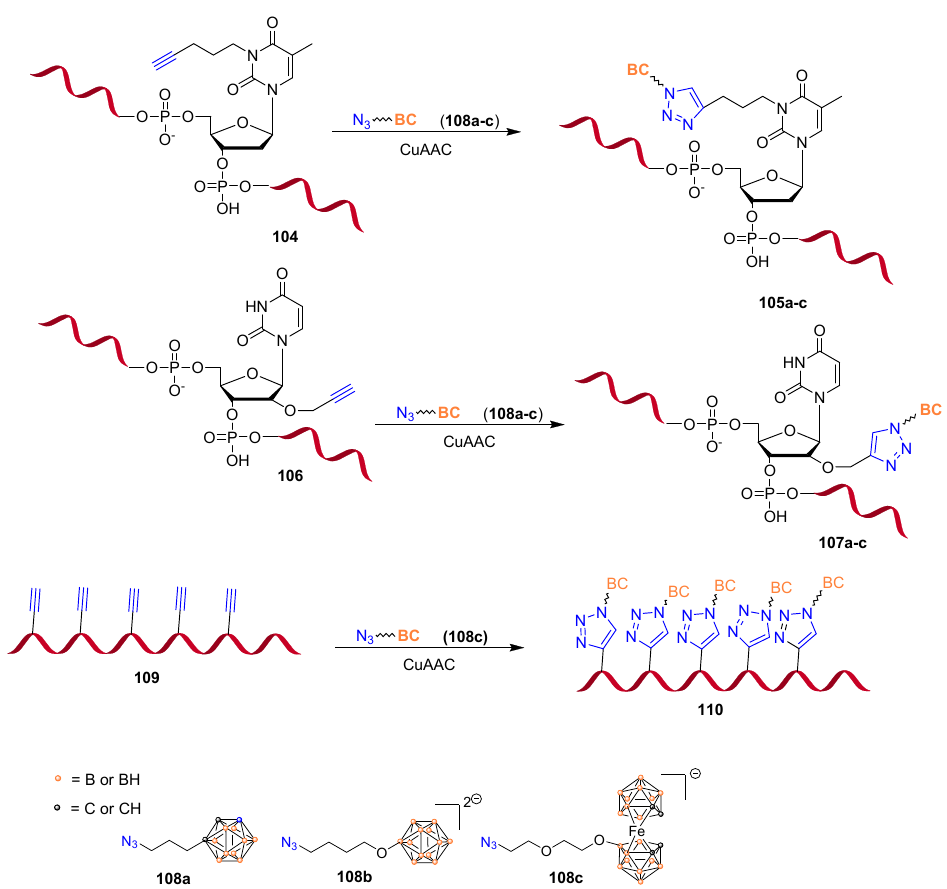
Scheme 27. Synthesis of boron-cluster-modified anti-EGFR antisense oligonucleotides. Click reaction conditions: azide (50 eq.), CuSO 4 /TBTA (1:1) (25 eq.), NaAsc (40 eq.), DMSO/tBuOH/H 2 O (3:1:1), 4 h, r.t. (61%